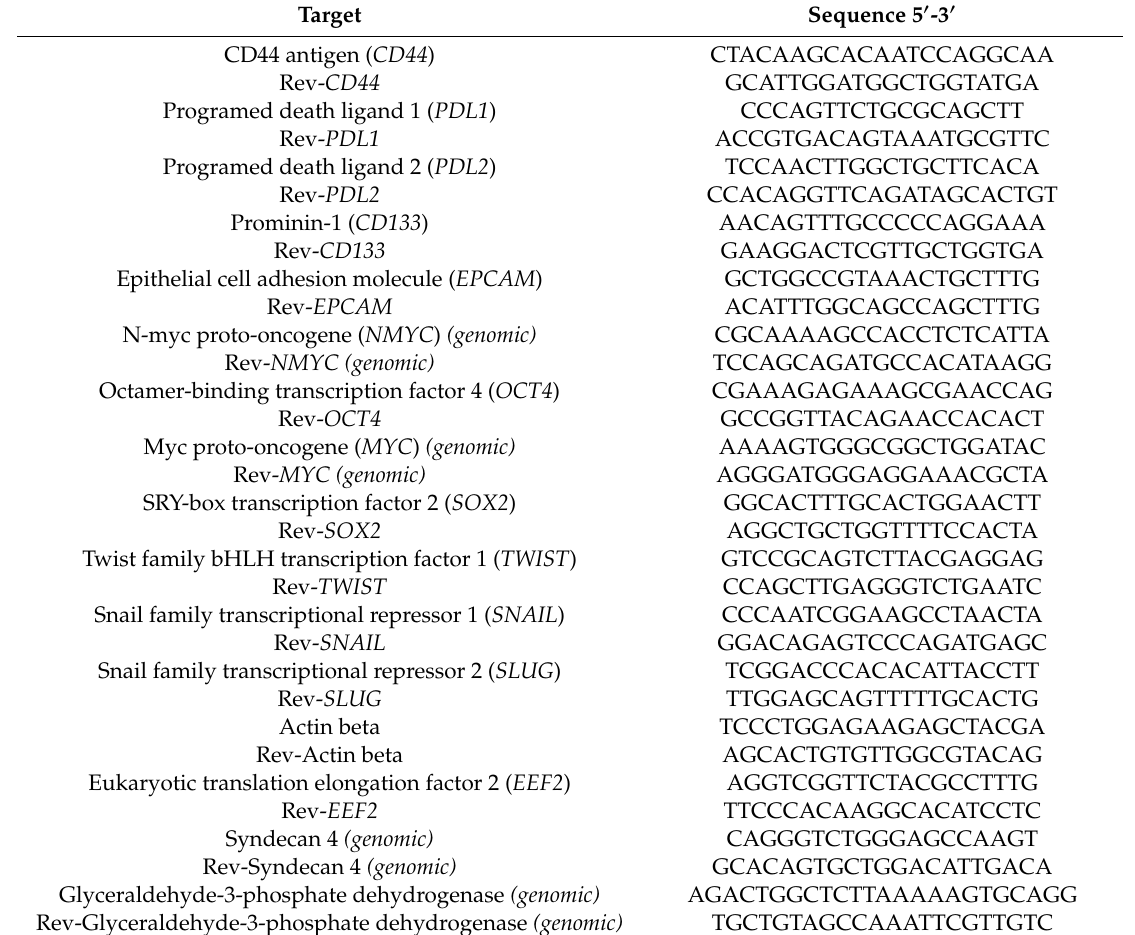
Table 1. Primer sequences for quantitative polymerase chain